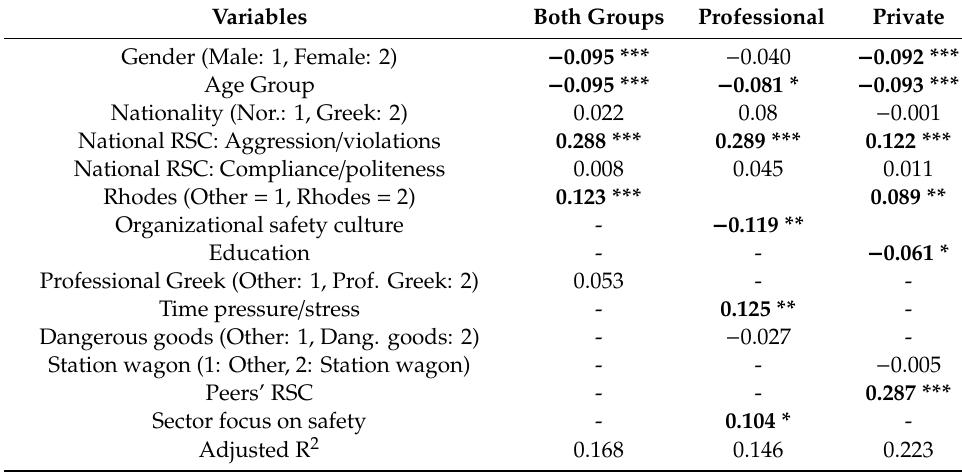
Table 9. Linear regression analyses for three groups. Dependent variable: “Aggressive violations”. Standardized beta coe ffi